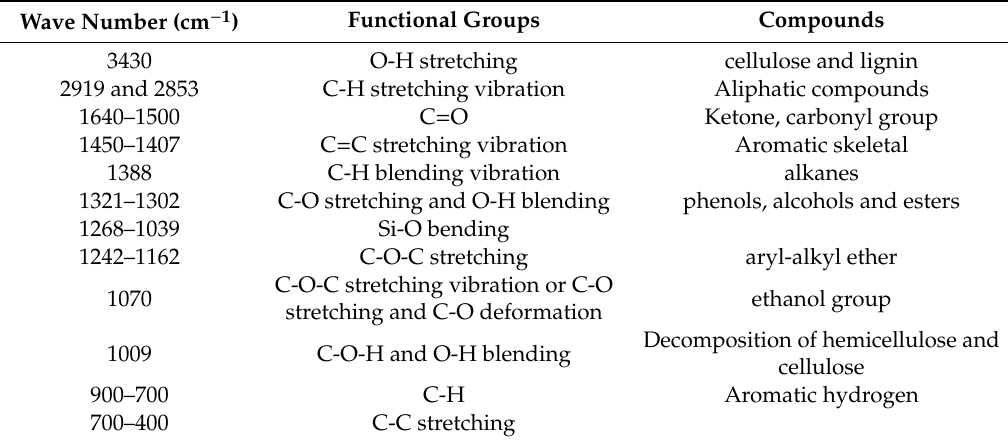
Table 1. Typical absorption bands and the main functional groups of rice